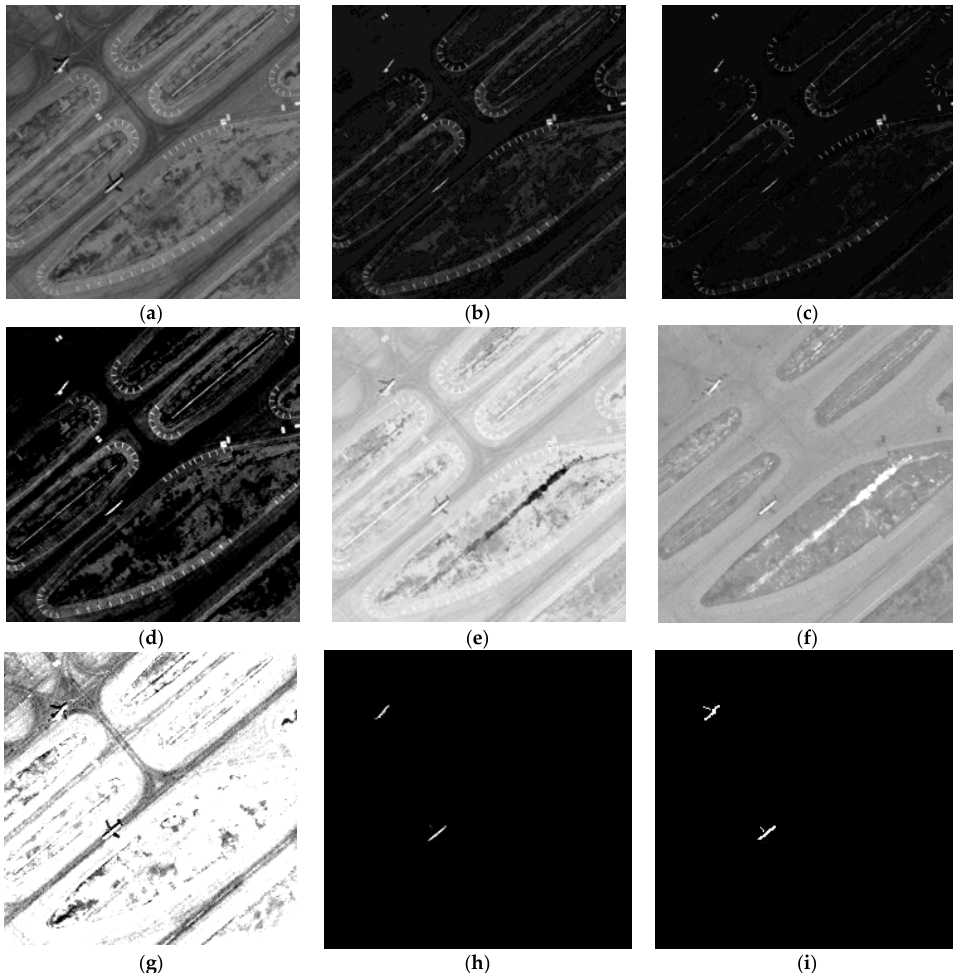
Figure 4. Detection results of the first scene of Xianyang Airport: ( a – c ) results of the hierarchical Constrained energy minimization (hCEM) algorithm for the first to third layers; ( d ) results of Constrained energy minimization (CEM) algorithm; ( e ) results of Spectral angle mapper (SAM) algorithm; ( f ) results of Clever eye (CE) algorithm; ( g ) results of MPCEM (Matrix principal Constrained energy minimization) algorithm; ( h ) results of Sparse weighted-based Constrained energy minimization (SWCEM) algorithm; and ( i ) reference data.